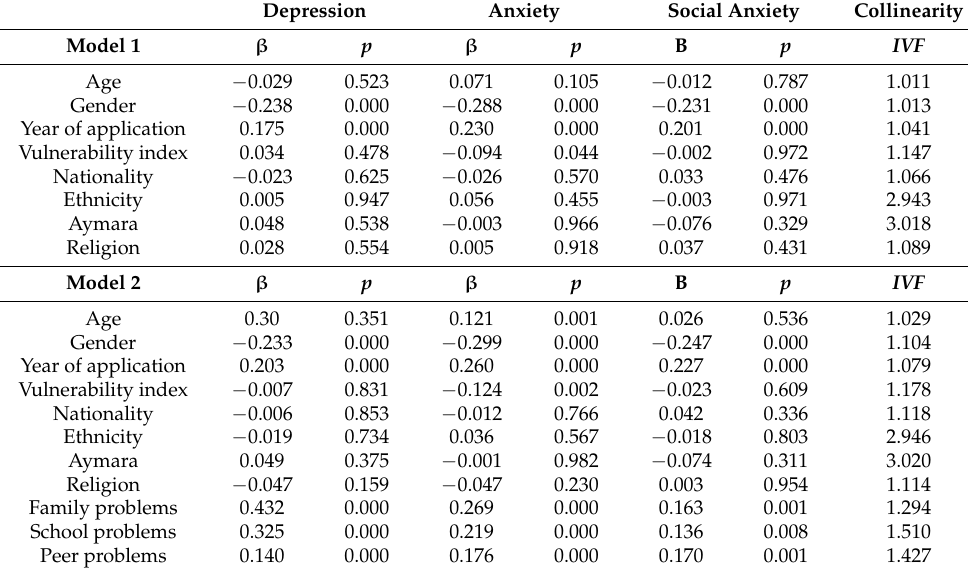
Table 5. Standardized